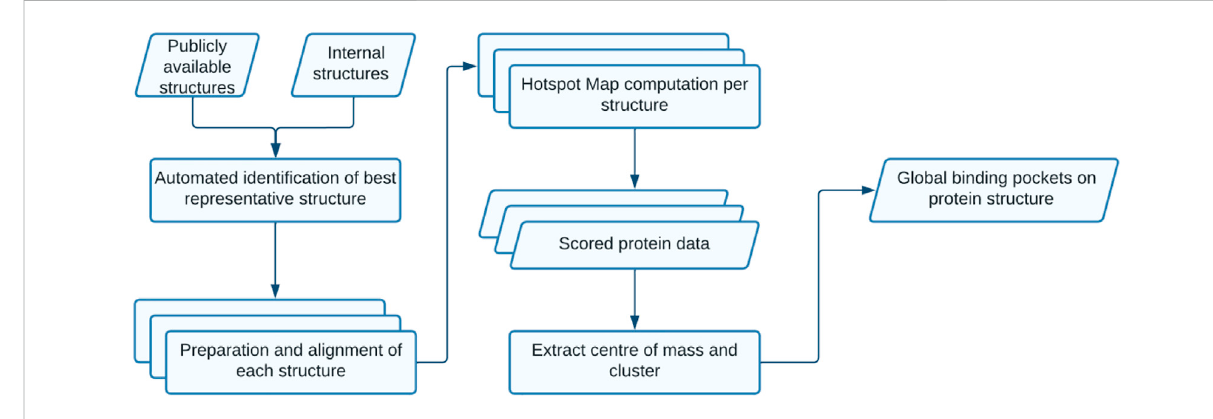
FIGURE 1 High-level schematic showing the overall structure-based assessment work fl ow.